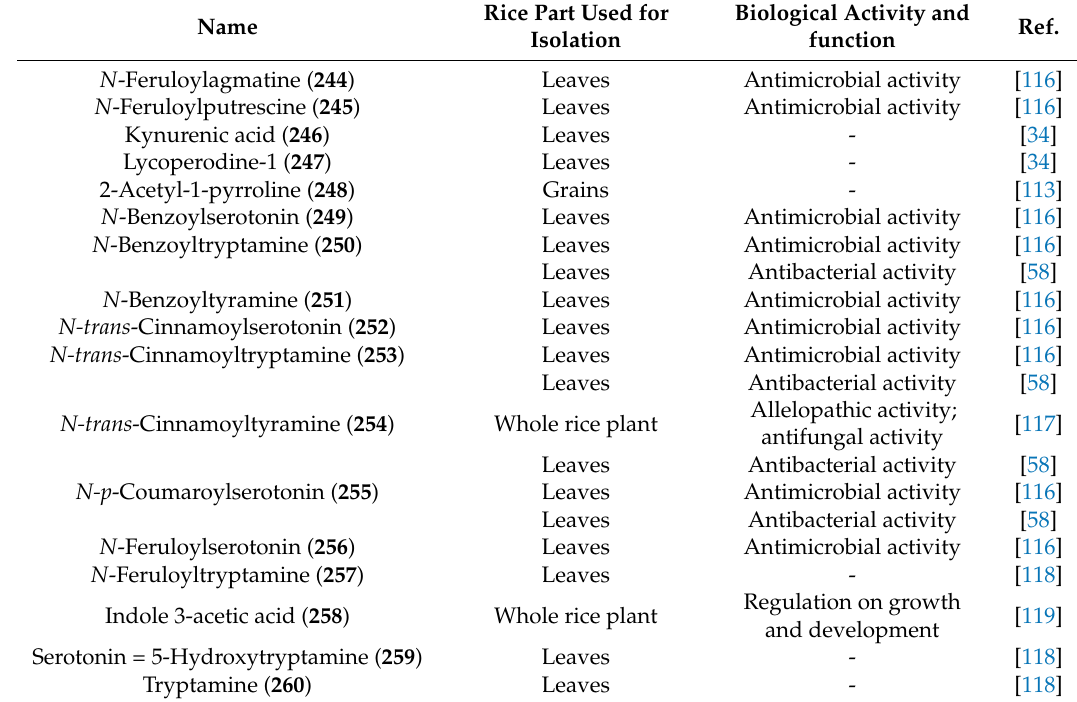
Table 8. Alkaloids and their biological